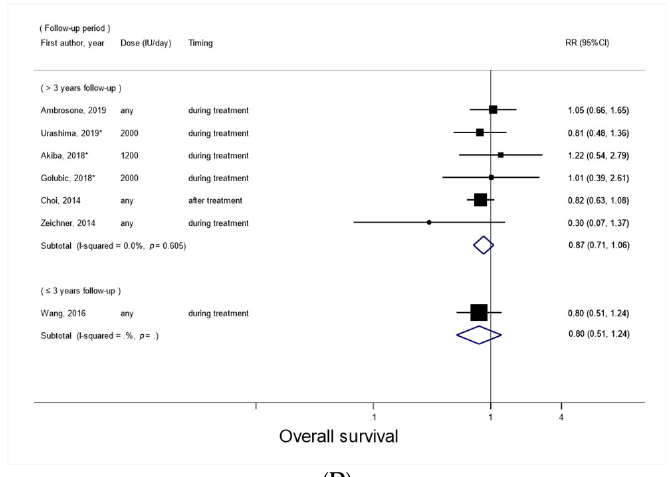
Figure 3. Forest plots for subgroup meta-analyses of post-diagnosis vitamin D supplement use and overall survival. ( A ) By study design; ( B ) By cancer type; ( C ) By timing of vitamin D supplement use; ( D ) By follow-up period. RCTs are marked with *.